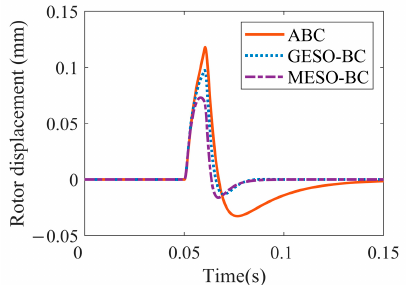
Figure 6. Response waveforms under 3 N pulse disturbance simulations.